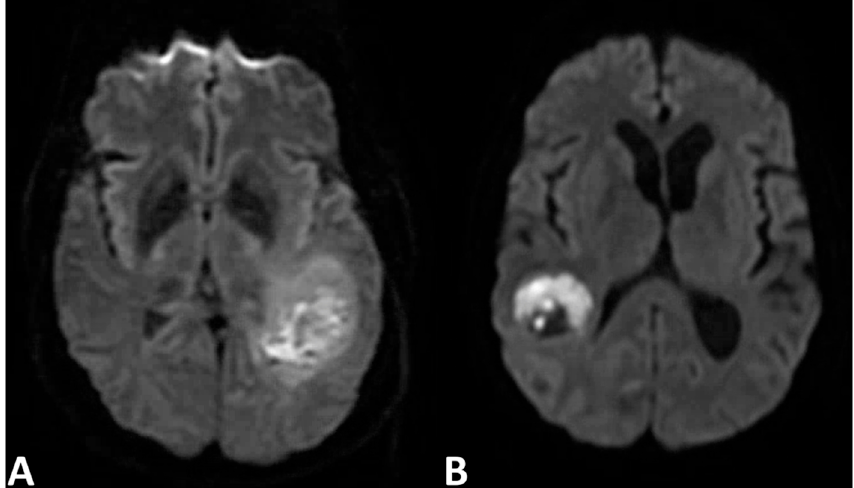
Figure 3. Diffusion-weighted imaging of ( A ) glioblastoma and ( B ) solitary intracranial metastasis with largely similar imaging features.